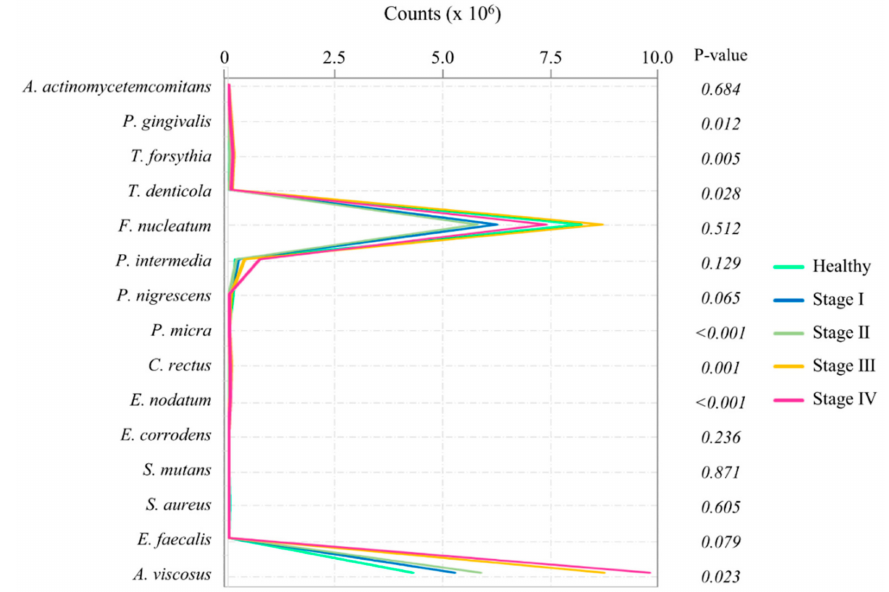
Figure 2. Changes in profiles of salivary bacteria according to stages of periodontitis ( × 10 6